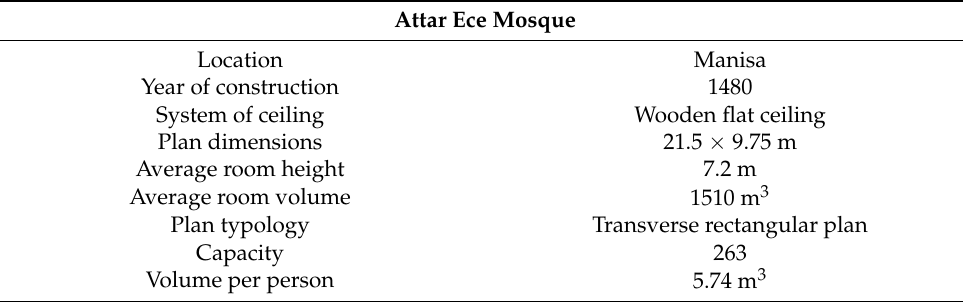
Table 4. The architectural features of Attar Ece Mosque.